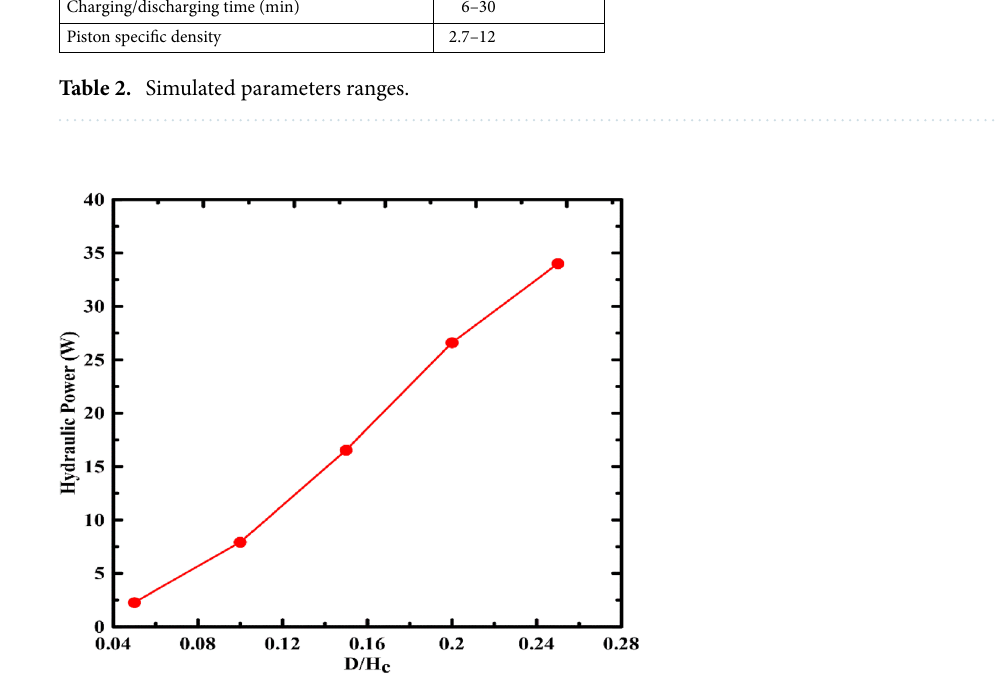
Figure 3. Hydraulic power versus diameter to container height